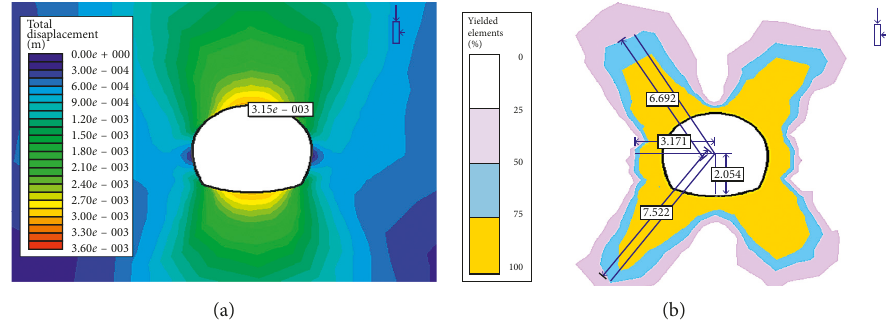
Figure 4: Total displacement (a) and yield elements (b) with plastic zone (50%) before supports.